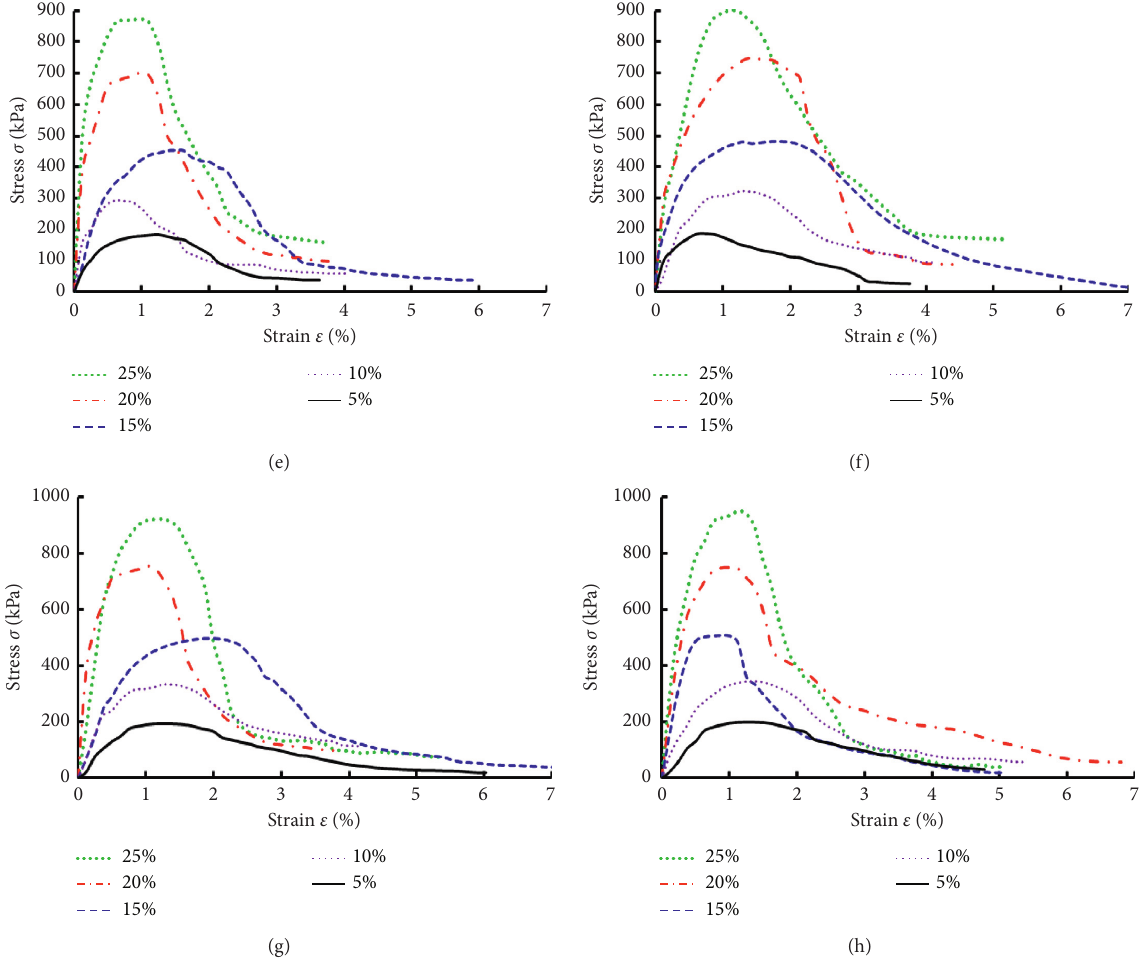
Figure 6: Axial stress and axial strain curves of CMS. (a) 7d axial stress and axial strain curves. (b) 14d axial stress and axial strain curves. (c) 28d axial stress and axial strain curves. (d) 56d axial stress and axial strain curves. (e) 90 d axial stress and axial strain curves. (f) 120d axial stress and axial strain curves. (g) 150d axial stress and axial strain curves. (h) 180d axial stress and axial strain curves.